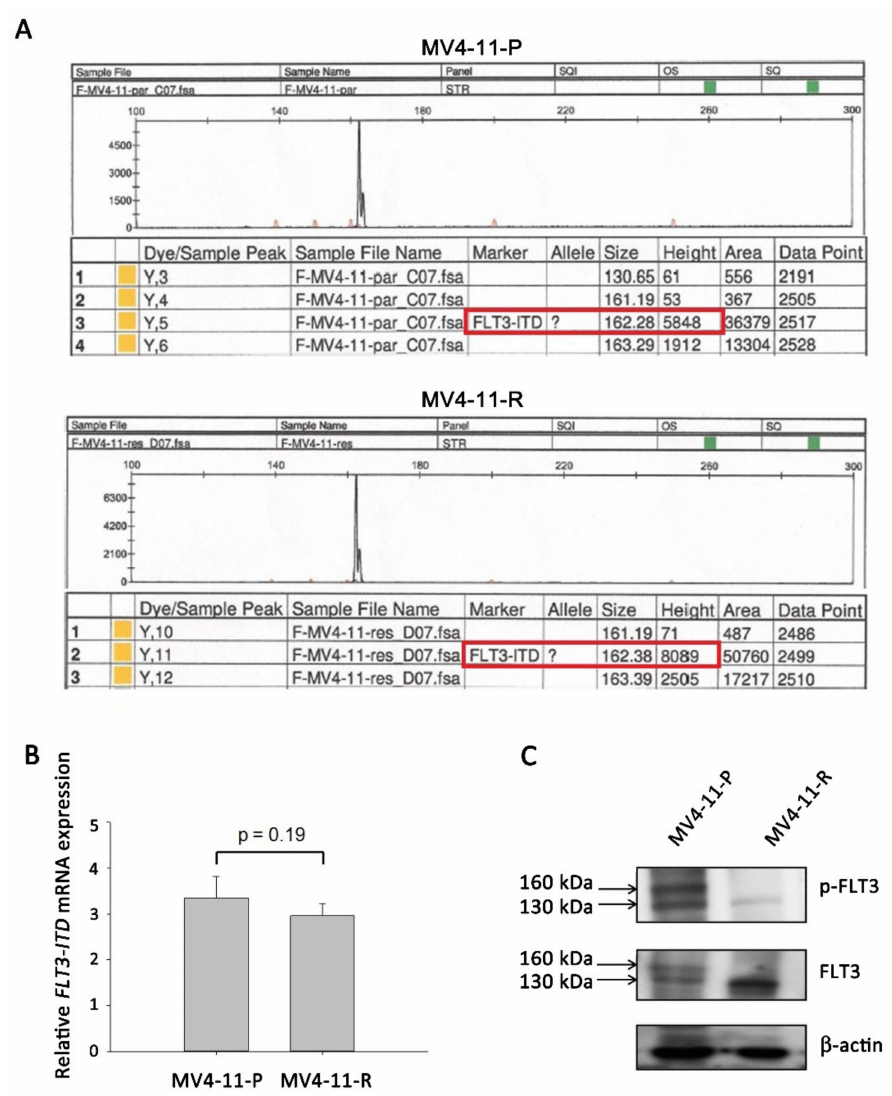
Figure 1. FMS-like tyrosine kinase 3 internal tandem duplication ( FLT3 -ITD) mutation and protein expression were detected in MV4-11-P and MV4-11-R cells. ( A ) GeneScan analysis showed the presence of the FLT3 -ITD mutation (162bps, red frame) instead of wildtype FLT3 (130bps) in both MV4-11-P and MV4-11-R cells. ( B ) FLT3 -ITD mRNA expression was revealed by qPCR. Data are representative of two independent experiments each performed in triplicate. ( C ) Total and phosphorylated FLT3 protein was observed in mature (160 kDa) and immature (130 kDa) forms. Representative Western blots of three independent experiments are